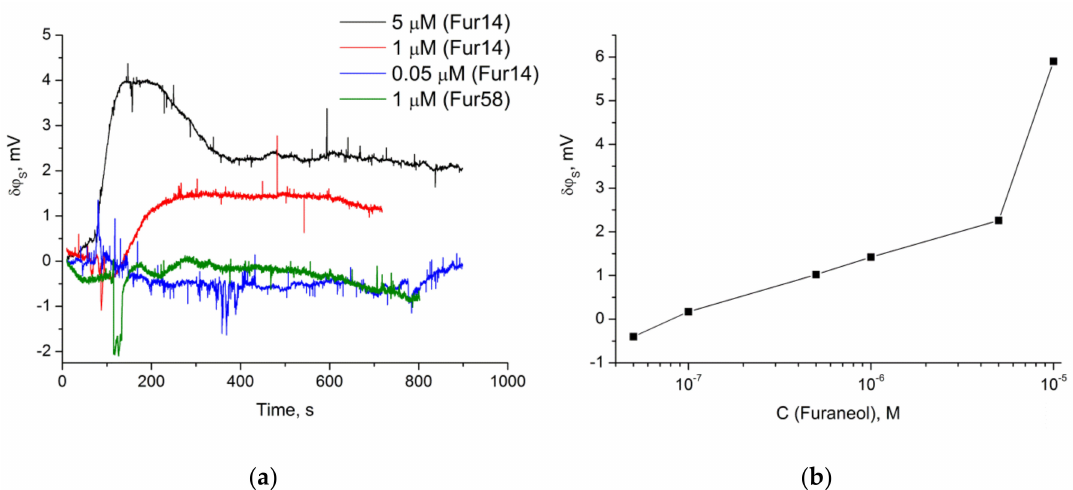
Figure 6. ( a ) Real-time signal of the ISFET modified with Fur14 and Fur58 oligonucleotides, to the addition of furaneol at different concentrations. ( b ) Dependence of the biosensor signal at ~450 s, after furaneol addition onto the target concentration. ISFET was modified with a Fur14